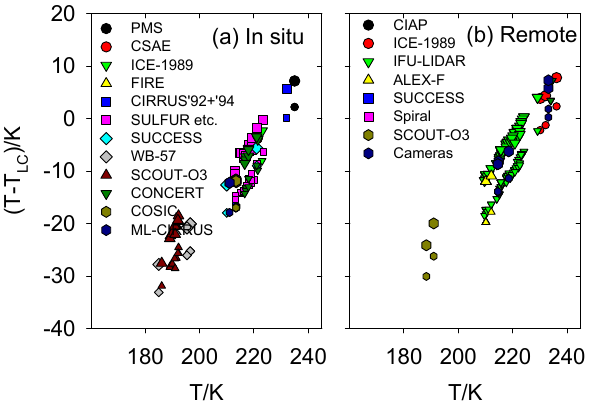
Figure 6. Difference between ambient temperature ( T ) and the threshold temperature ( T LC ) versus T for (a) in situ and for (b) re- mote sensing contrail observations. The larger symbols depict T − T LC when T LC is computed for the measured or estimated humidity, and the smaller symbols when computed for assumed liquid satura- tion. The symbols refer to the same projects as in Figs. 1 and 2 (WB-57 refers to CRYSTAL-FACE and CR-AVE, which both used this